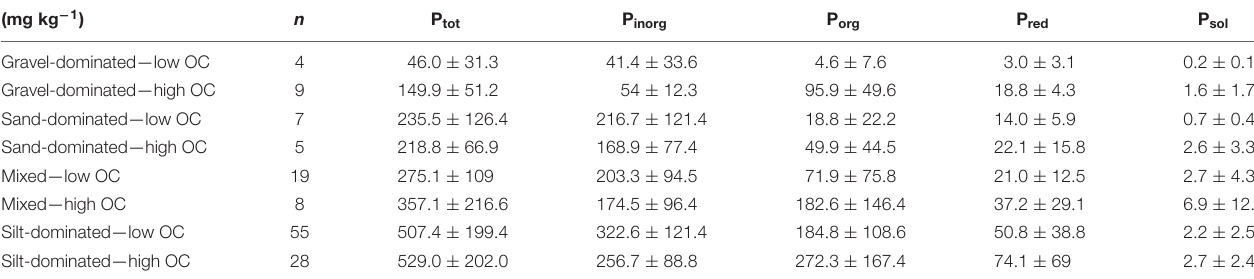
TABLE 3 | Concentration of P-fractions per sediment type; units in mg kg − 1